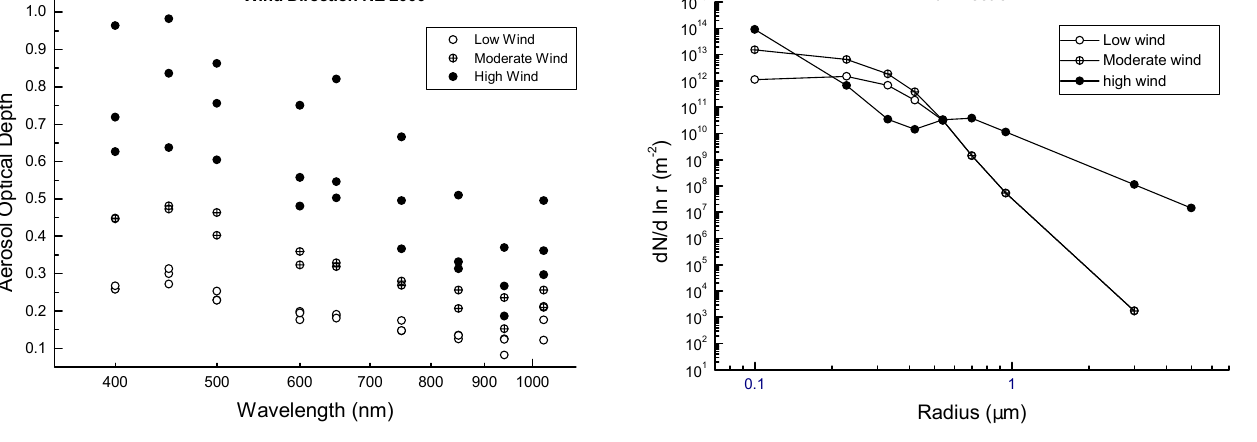
Fig. 7. Spectral variation of aerosol optical depths for different northeast (NE) wind conditions.